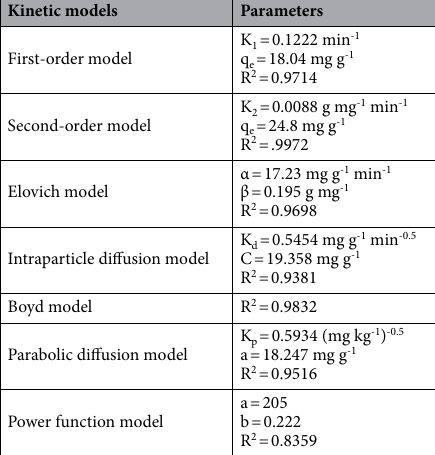
Table 1. Constants and coefficients of determination of pseudo-first-order, pseudo-second-order, Elovich, Boyd, parabolic diffusion and power function kinetic models.